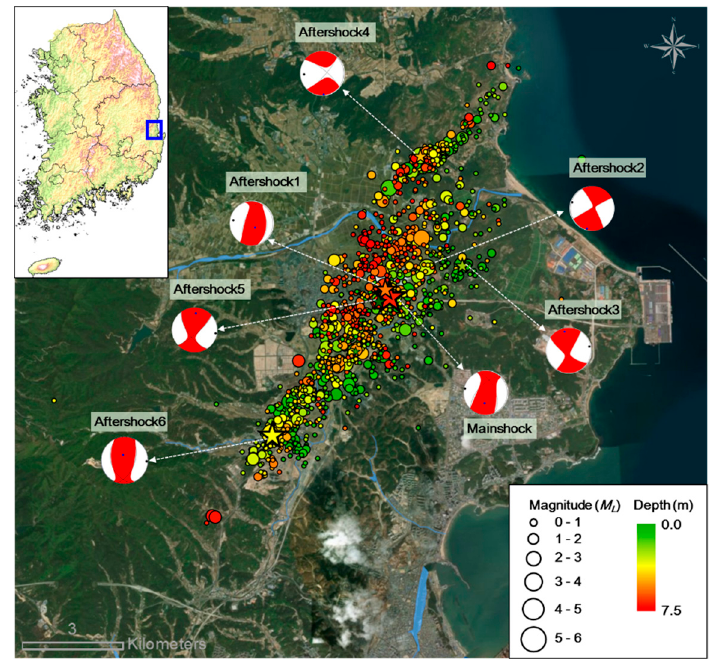
Figure 1. Epicenters and fault-plane solutions of the 2017 Pohang earthquake [2].